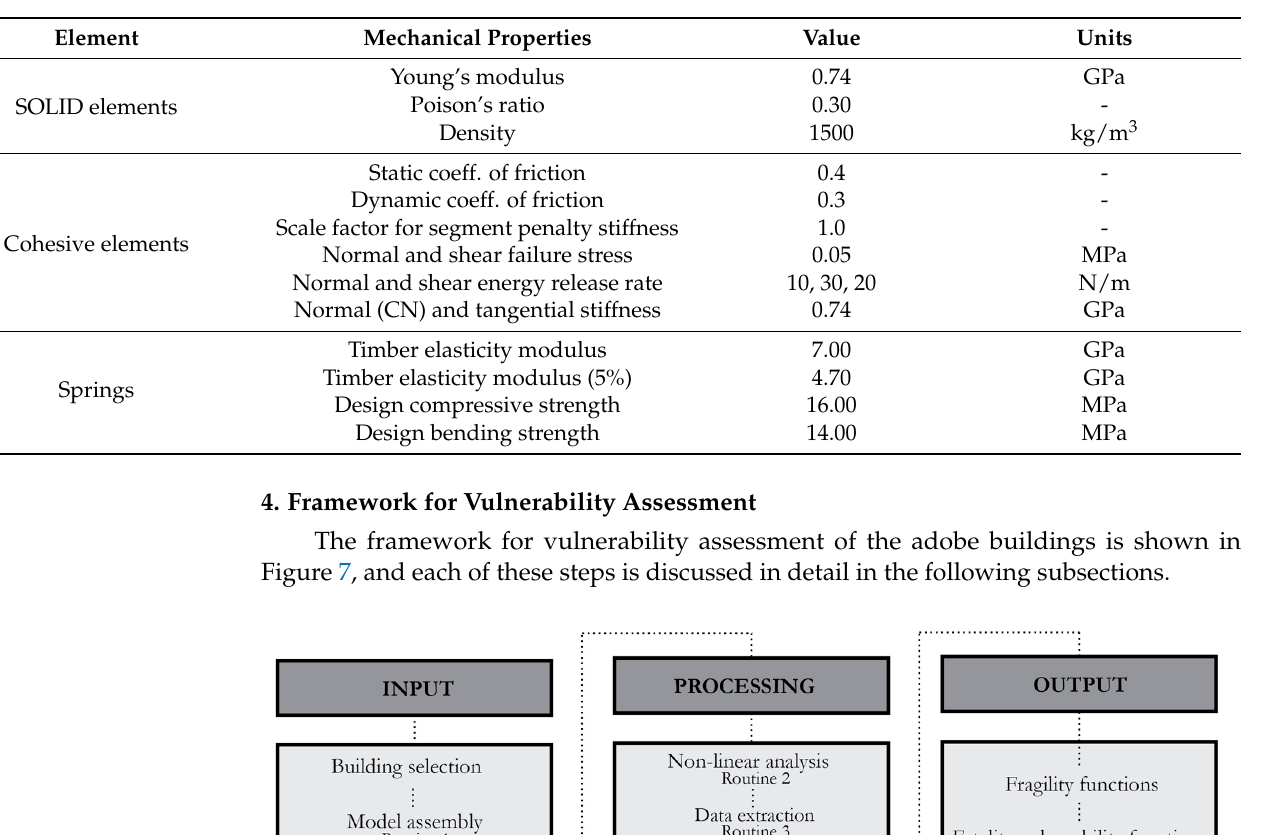
Table 2. Mechanical properties and input parameters of the numerical models.